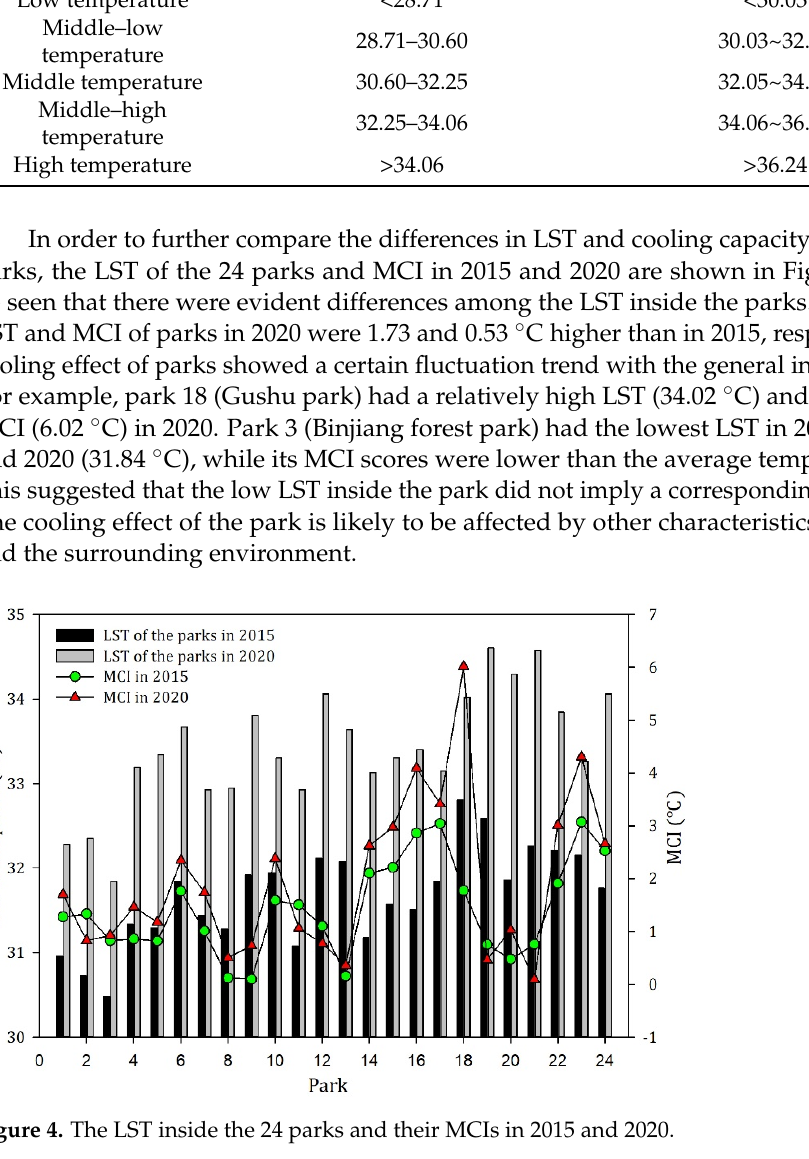
Table 3. Classification of Land Surface Temperature in Shanghai.